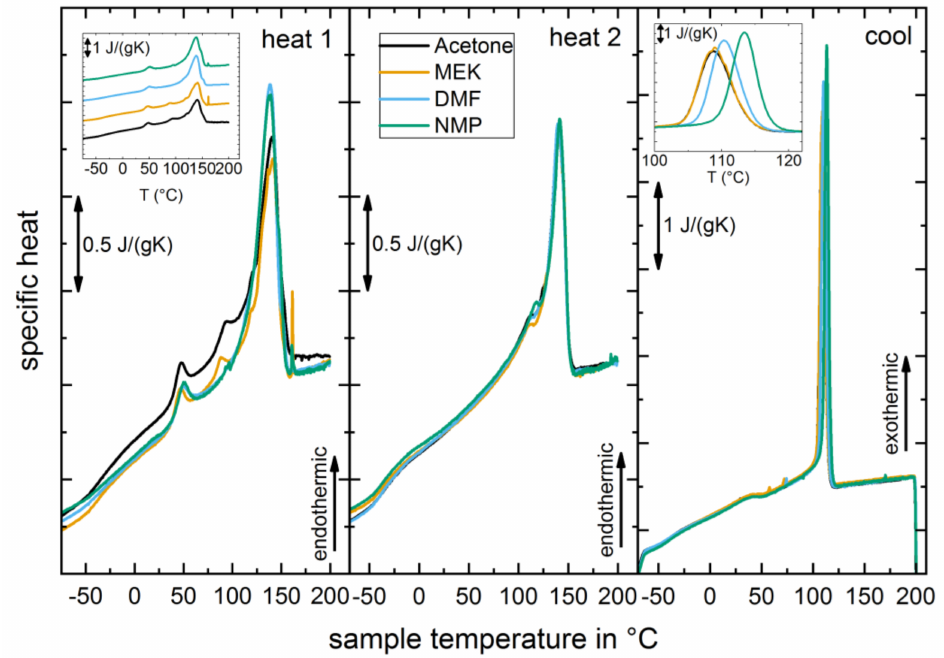
Figure 2. DSC thermograms of P(VdF-HFP) films processed from different solvents. Heating run 1 ( left ), heating run 2 ( center ), and cooling run ( right